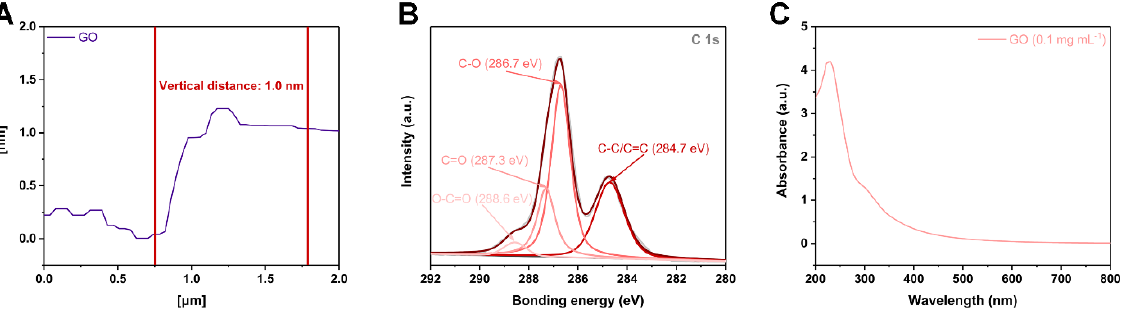
Figure 3. ( A ) Thickness of GO as measured by atomic force microscopy. ( B ) C1s High-resolution XPS spectra of GO. ( C ) UV-Vis spectrum of GO (0.1 mg mL − 1 ).